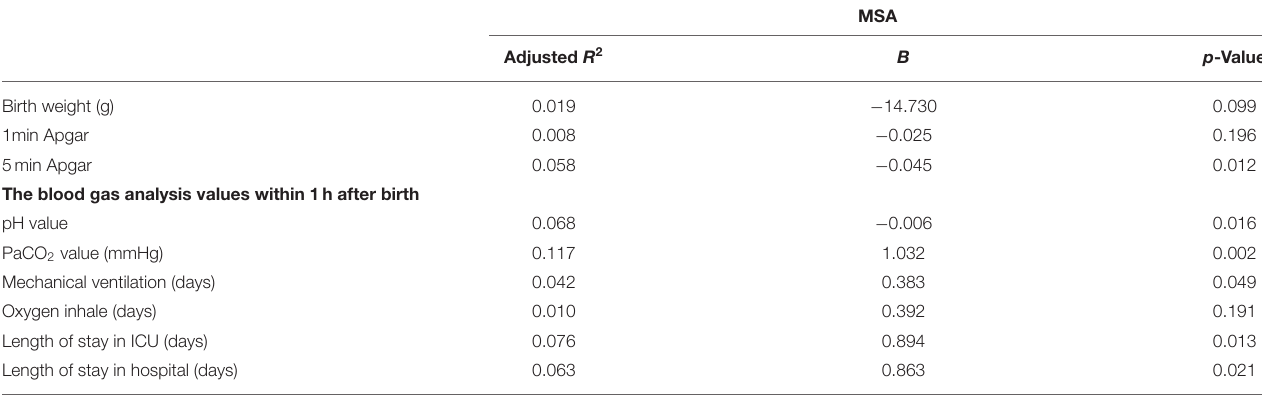
TABLE 4 | Association between MSA value and neonatal clinical outcomes.